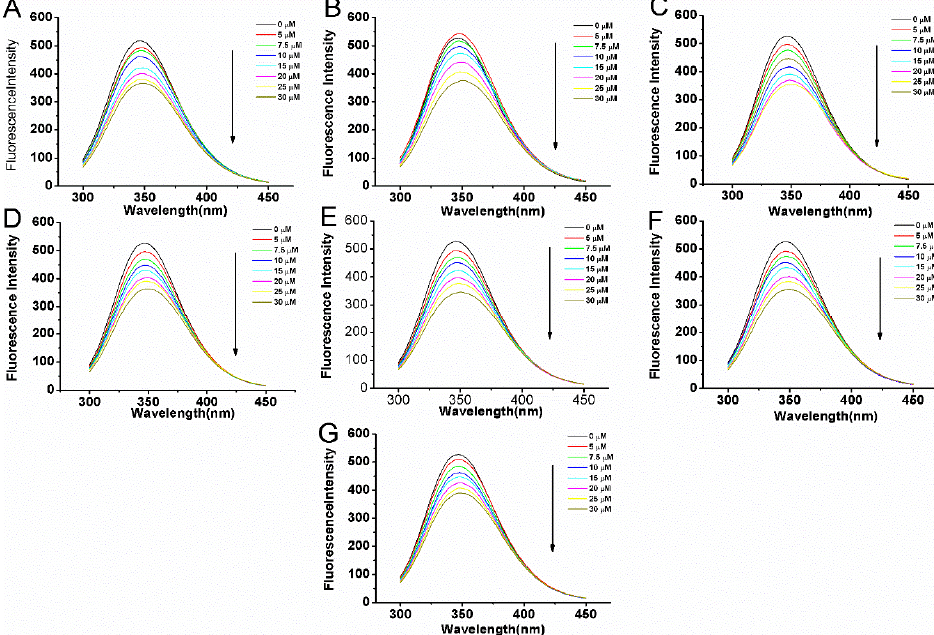
Figure 3. The fluorescence quenching spectra of BSA (5 μ M) with variable concentrations of compounds 1 ( A ), 2 ( B ), 3 ( C ), 4 ( D ), 5 ( E ), 6 ( F ), 7 ( G ) at the excitation wavelength (280 nm) in 0.05 mol L − 1 Tris-HCl, pH 7.4. The concentrations of compounds varied from 0 to 30 μ M.